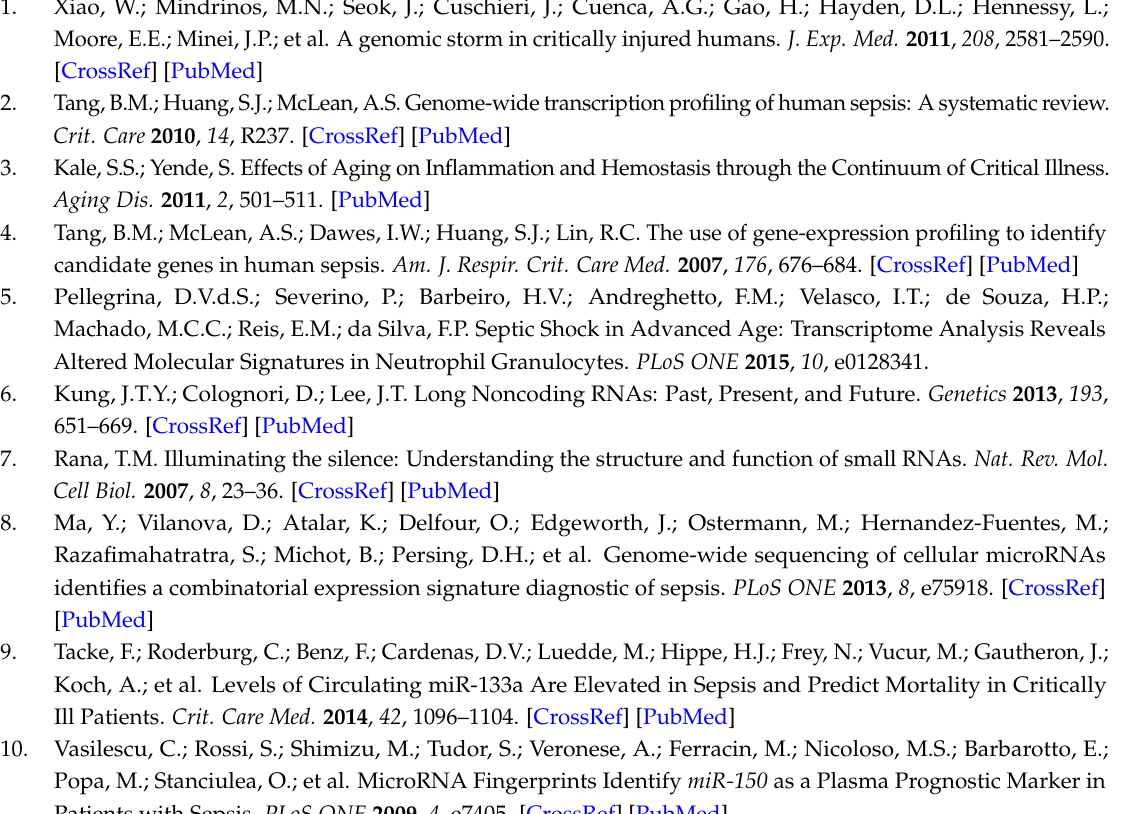
Figure S3: Elderly and adult co-expression networks of ncRNAs and protein-coding mRNAs in molecular pathways enriched among the top 15% most connected or the top 20% most differentially connected genes, Figure S4: Genomic context of lncRNAs differentially expressed in sepsis and displaying high connectivity in gene co-expression networks, Table S1: List with all detected array probes along with their gene type (protein-coding, lncRNA, pseudogene, poorly annotated), gene ID, chromosomal location, relative expression between septic and control samples, associated p